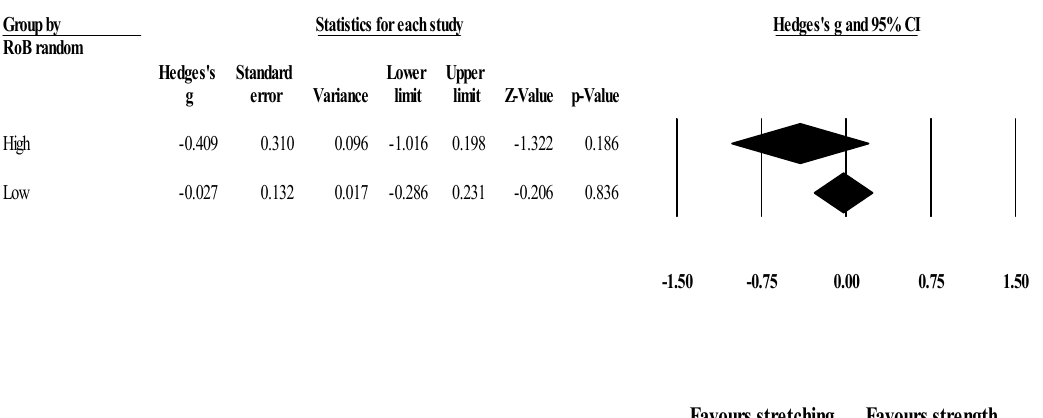
Figure 3. Forest plot of changes in ROM after participating in stretching-based compared to Scheme 95. confidence intervals (CI).